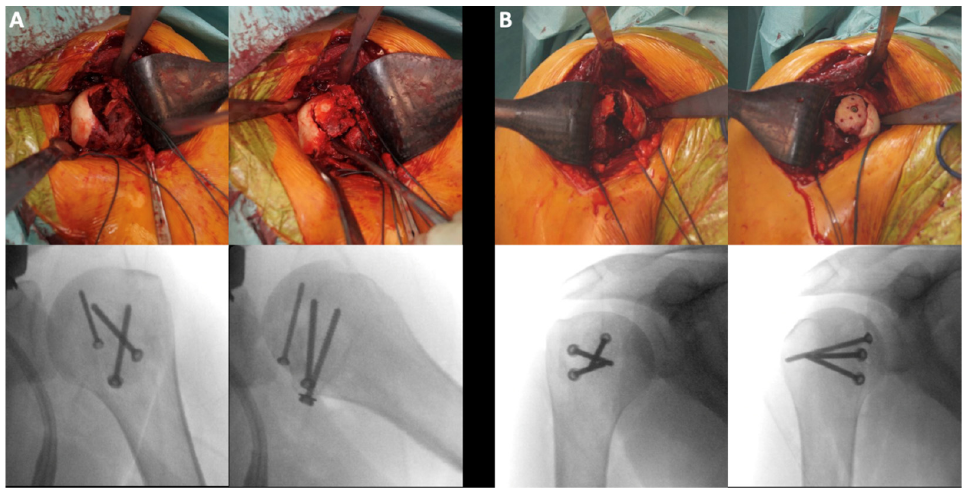
Figure 1. 33 ‐ year old male patient after an epileptic seizure: bilateral posteriorly dislocated impression type fractures of the proximal humerus; ( A ) intraoperative pictures and X ‐ rays of the left proximal humerus: open reduction, allo ‐ and autograft, fixation with three screws (3.5 mm + 2.7 mm); ( B ) intraoperative pictures and X ‐ rays of the right proximal humerus: open reduction, allo ‐ and autograft, fixation with three screws (3.5 mm + 2.7 mm).